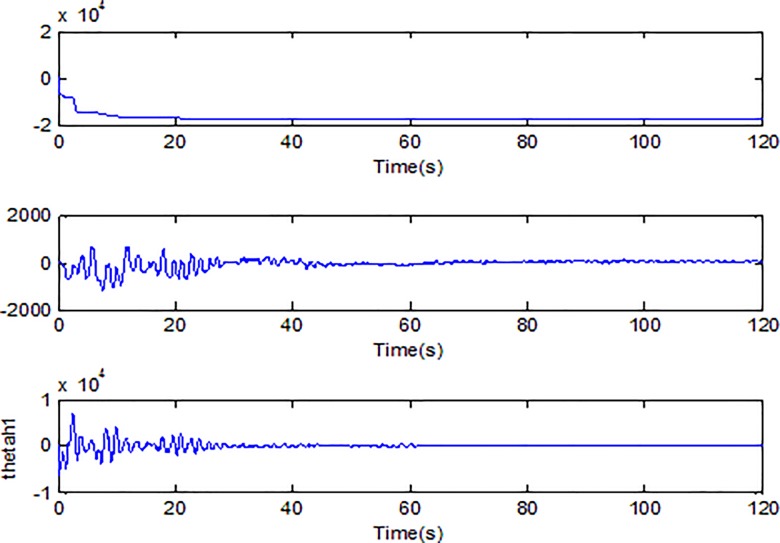
Adaption of θh along X axis.